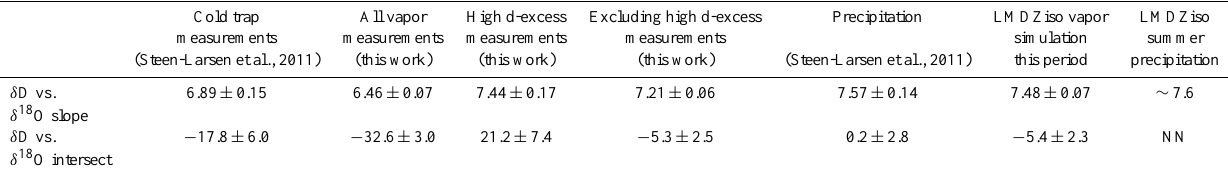
Table 3. Overview of slope and intersect for δ D vs. δ 18 O for observed and modeled water vapor and precipitation.